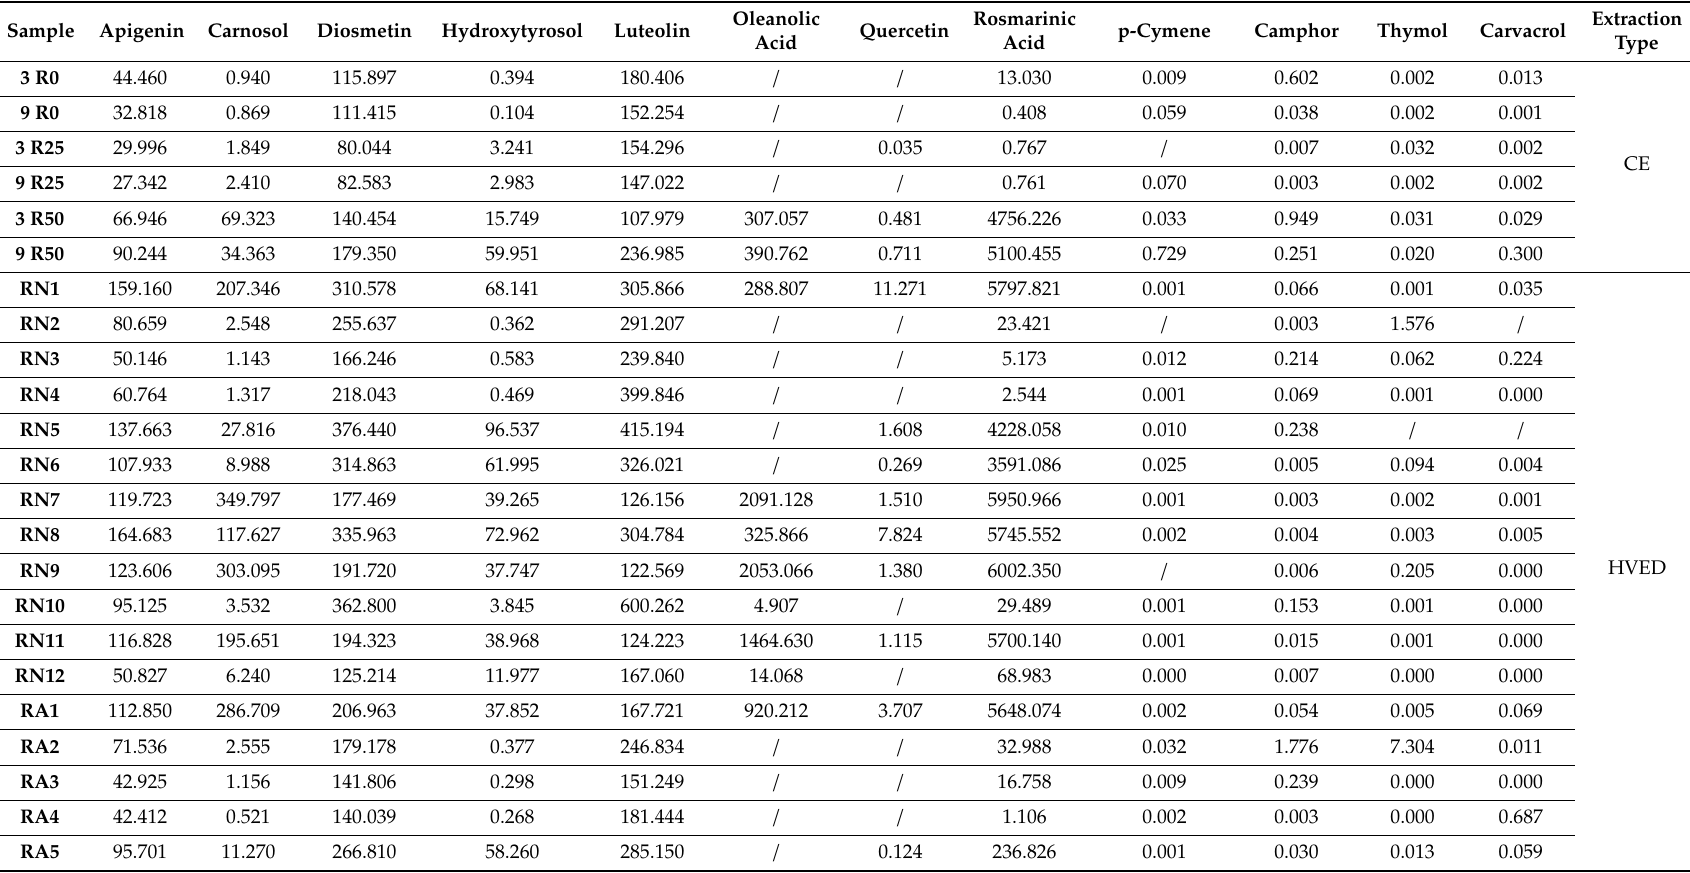
Table 5. Ultra-Performance Liquid Chromatography–Tandem Mass Spectrometry (UPLC–MS / MS) analysis of extractive compounds from rosemary (measurements for CE and HVED treated samples) (ng /